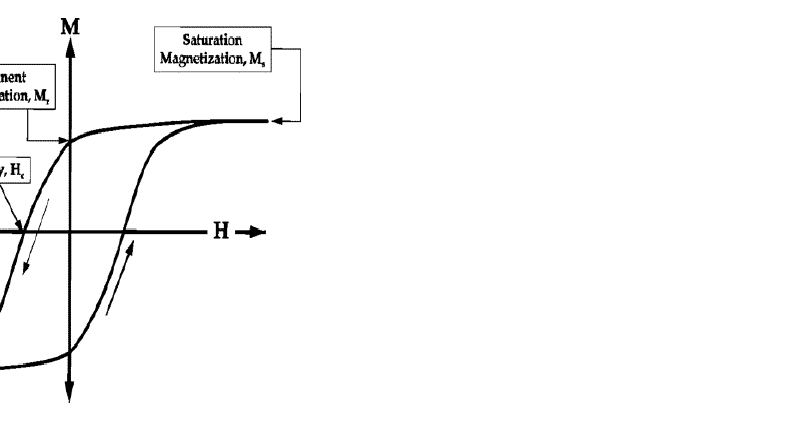
Figure 4. Hysteresis line diagram: Ms is the saturation magnetization strength; Mr is the remanent magnetization strength; Hc is the coercivity [44].